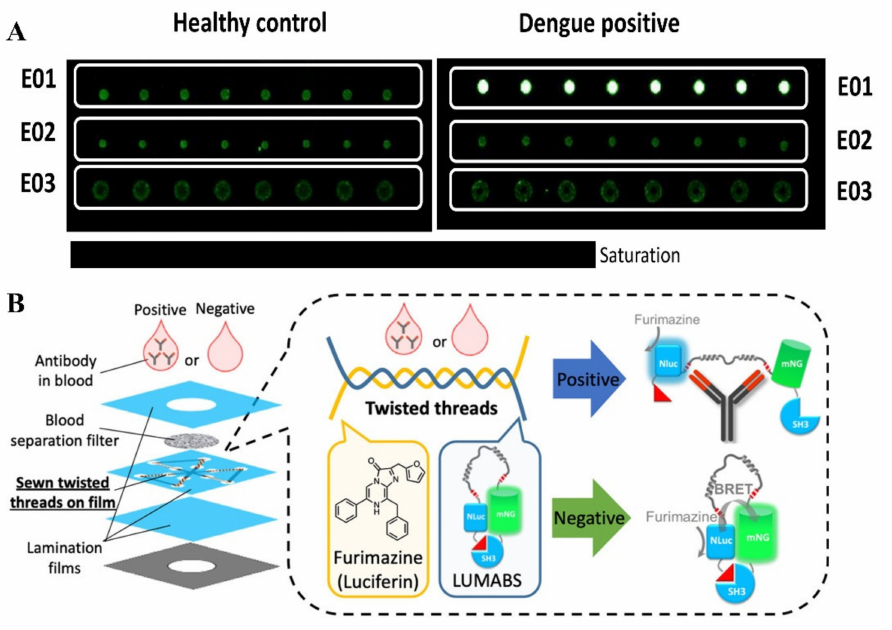
Figure 8. ( A )Detection of DENV using peptide microarrays. Differentiation of healthy and DENV infection patients’ sera by spotting the fluorescence (reprinted from [200]). ( B ) Detection of anti-DENV-1 antibody from whole blood using an intertwisted thread-based analytical device (Reprinted with permission from ref. [206]. Copyright 2020 American Chemical